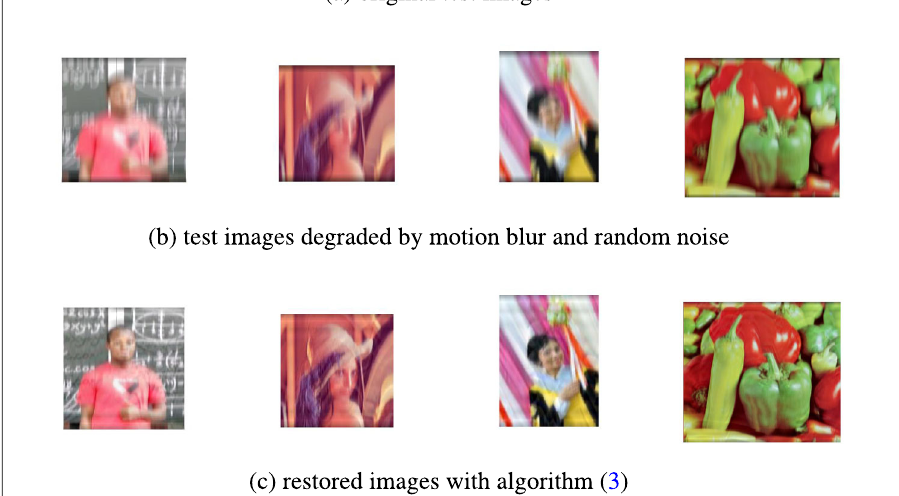
μ λ n = 0.95 and n = 0.00001. Finally, we used a tolerance of 10 of iterations (n) to be 100 for all the algorithms. The original test images (Abubakar, Bar- bra, Duangkamon and peppers) their degradation and restoration are presented in Figs. 1 and